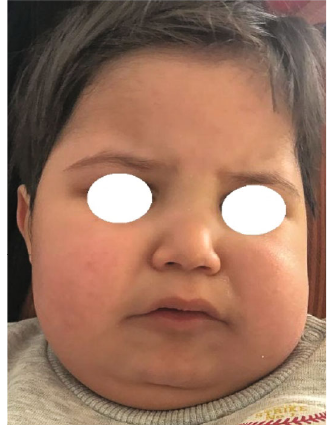
Figure 1: Head and neck examination.